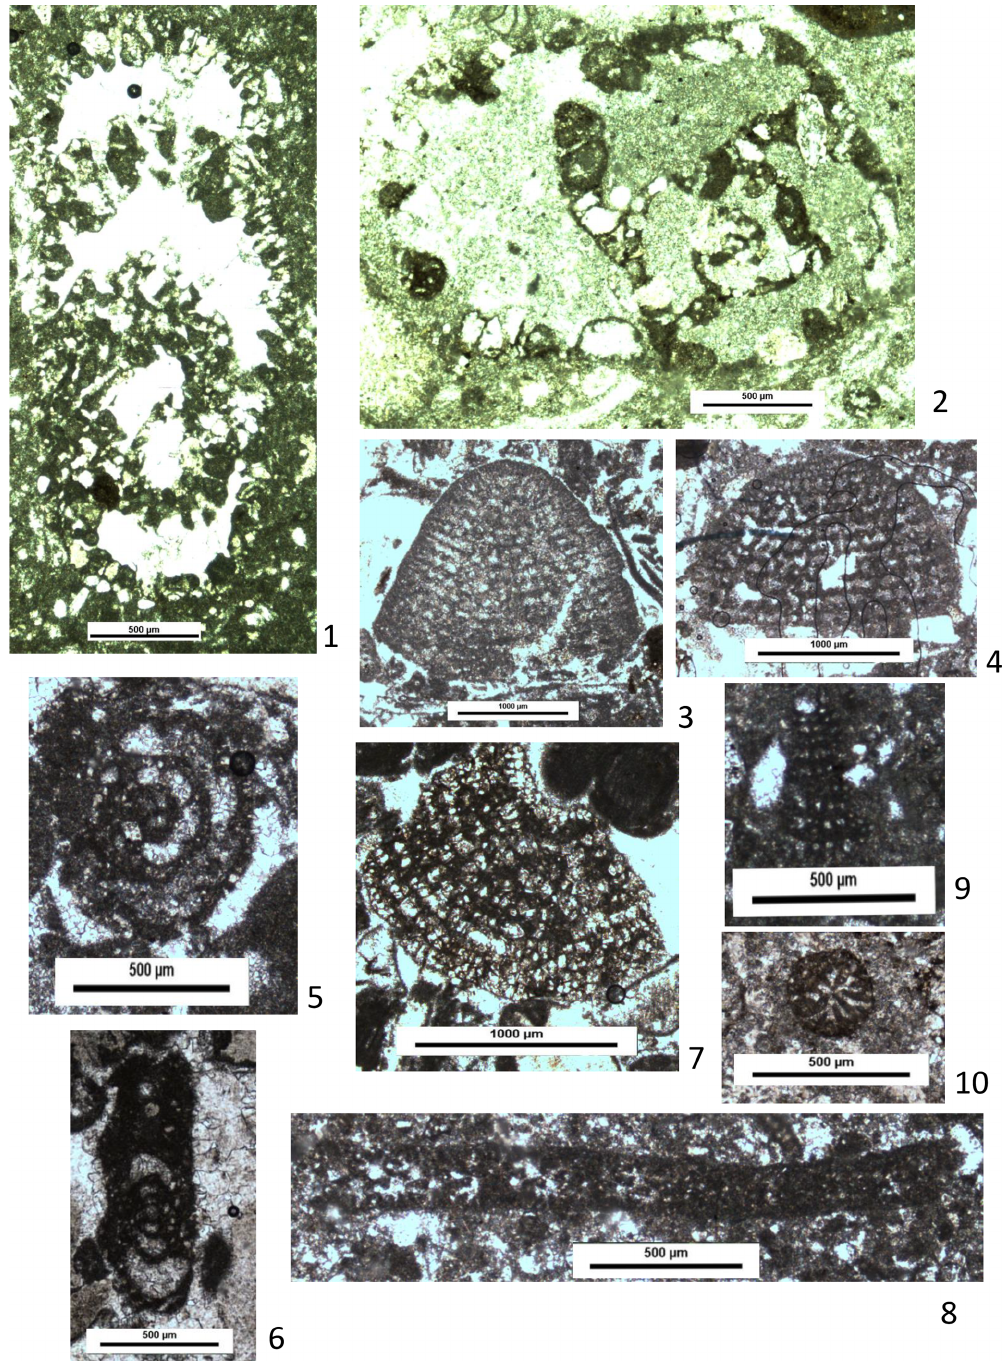
Figure 9. Thin-section photographs of benthonic foraminifera from the Derdere Formation at Derik: (1) Pseudocyclammina rugosa (d’Orbigny), sample DRK32; (2) Ammobaculites/Lituola sp., sample DRK35; (3, 4) indeterminate orbitolinid, samples DRK10 and DRK35; (5, 6) Charentia cuvillieri Neumann, sample DRK9; (7, 8) Cuneolina/Dicyclina sp., samples DRK9 and DRK34; (9, 10) Cune- olina/Vercorsella sp., samples DRK35 and